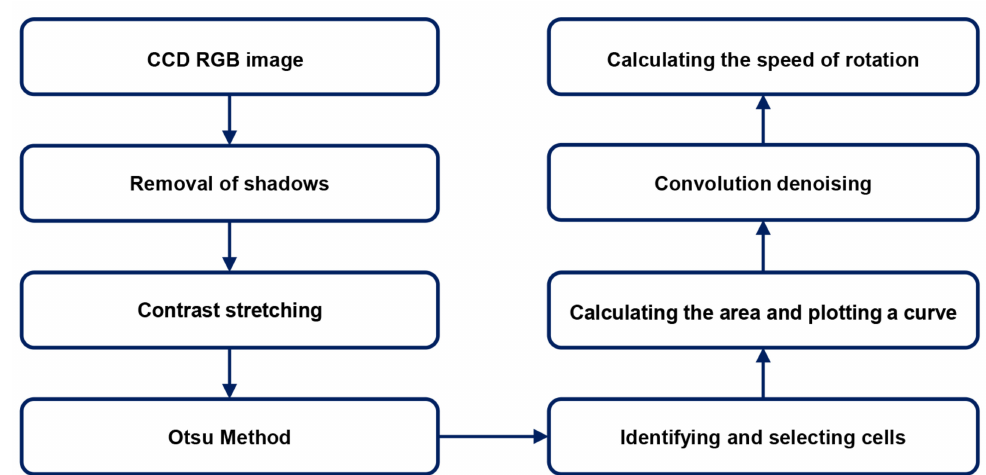
Figure 2. Flow chart of the algorithm for extracting cell speed based on area change.